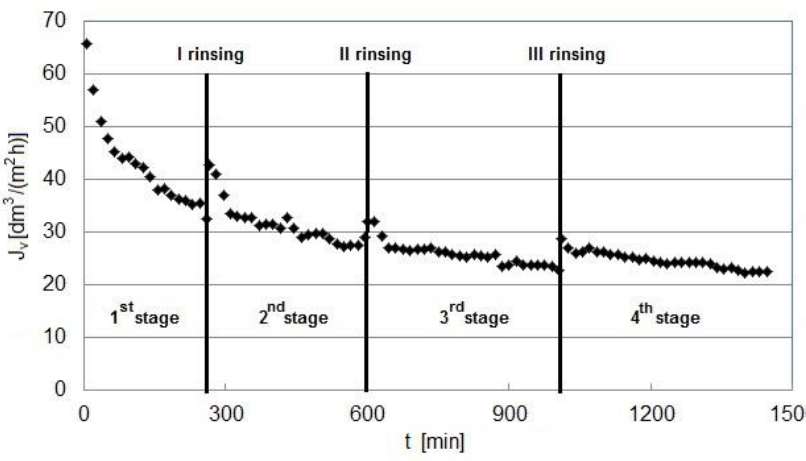
Figure 10. Permeate flux vs. time during multistage reverse osmosis of the MTW containing a nonionic surfactant (N-S3) (AG Osmonics membrane).